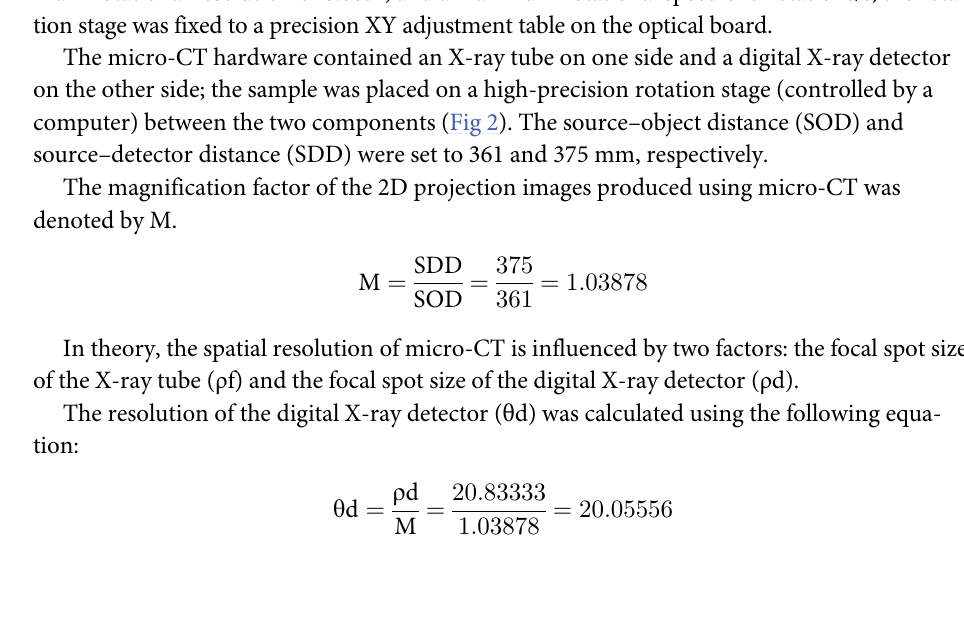
a precision XYZ adjustment table on the optical board using brackets. The rotation stage model was MR-60G (Tanlian E-O Co., Ltd., Taoyuan, Taiwan) with a maximum load of 50 N, a mini- mum rotational resolution of 0.005˚, and a maximum rotational speed of 5 rotations/s; the rota- tion stage was fixed to a precision XY adjustment table on the optical board.